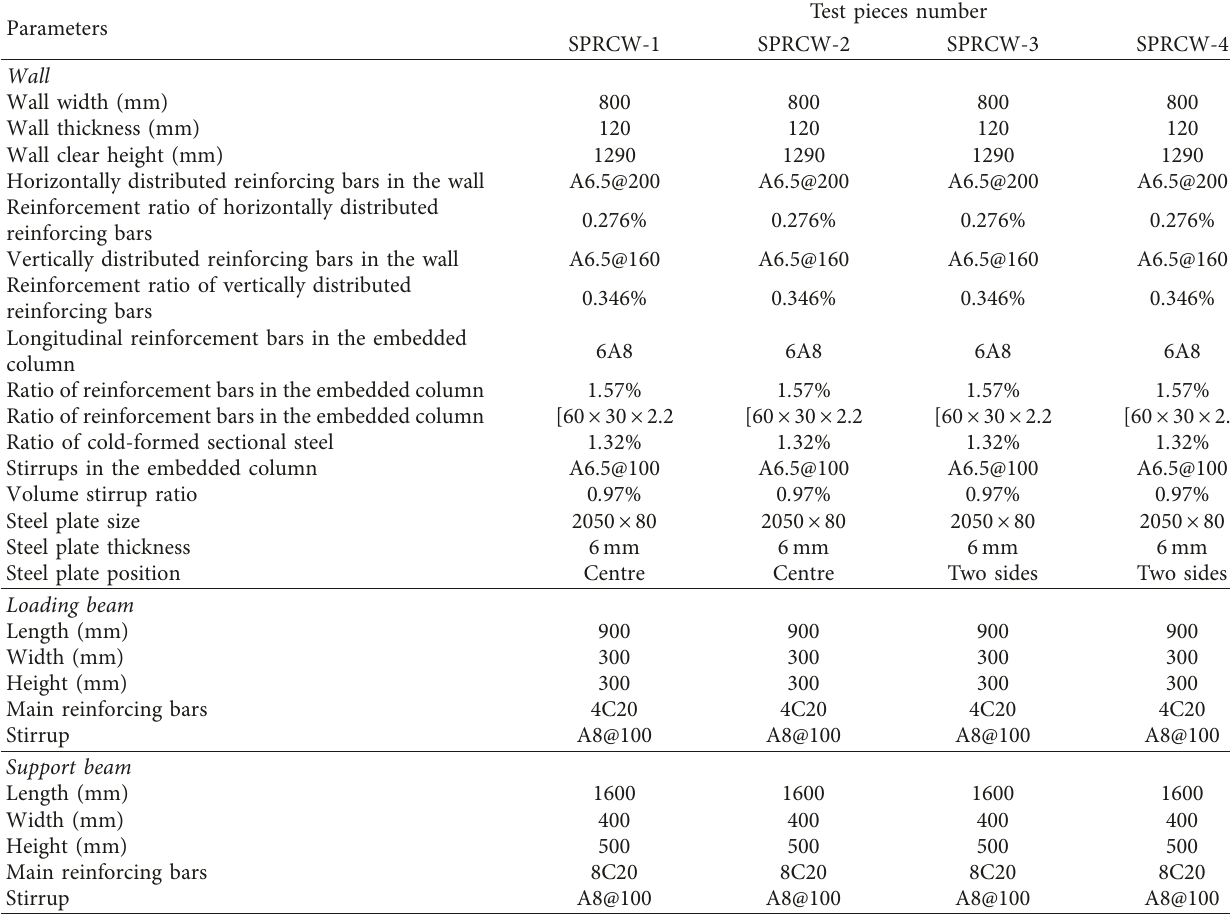
Table 1: Parameters of test